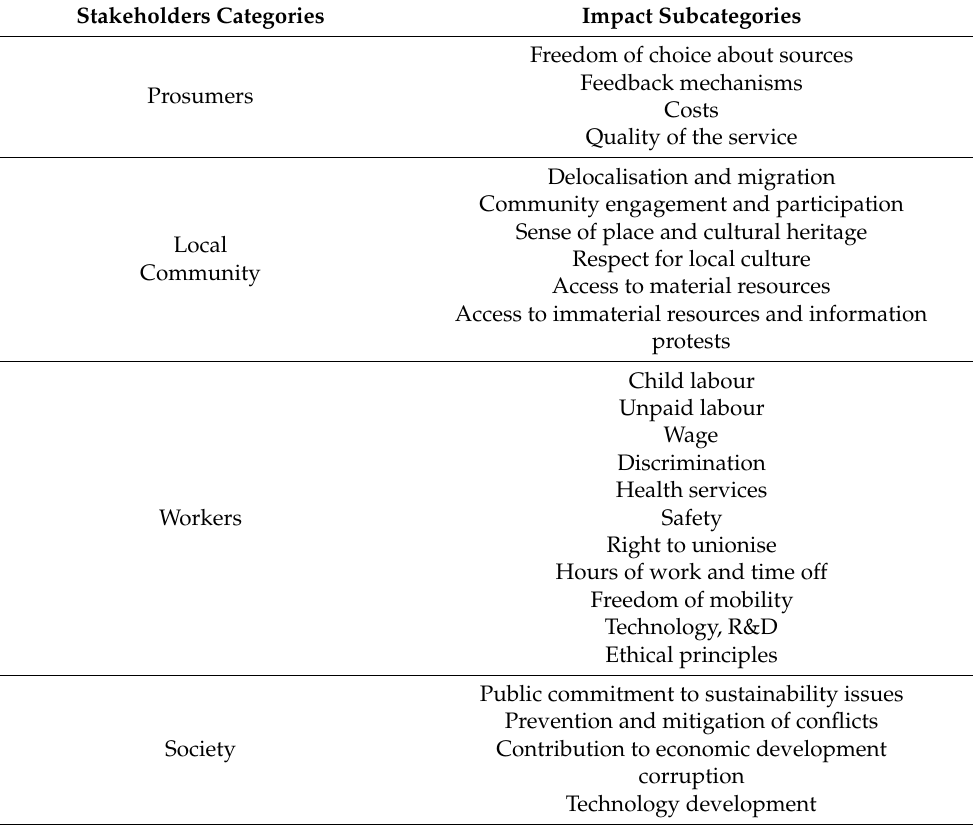
Table 2. Stakeholders categories and impact subcategories of Solidarity Oriented REC (adapted from